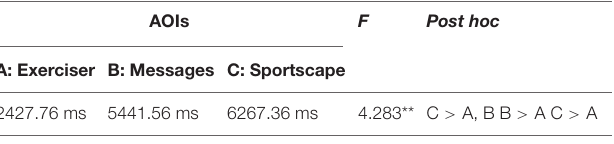
TABLE 8 | Total average duration of fixation on the different AOIs among the four conditions in the sports marketing